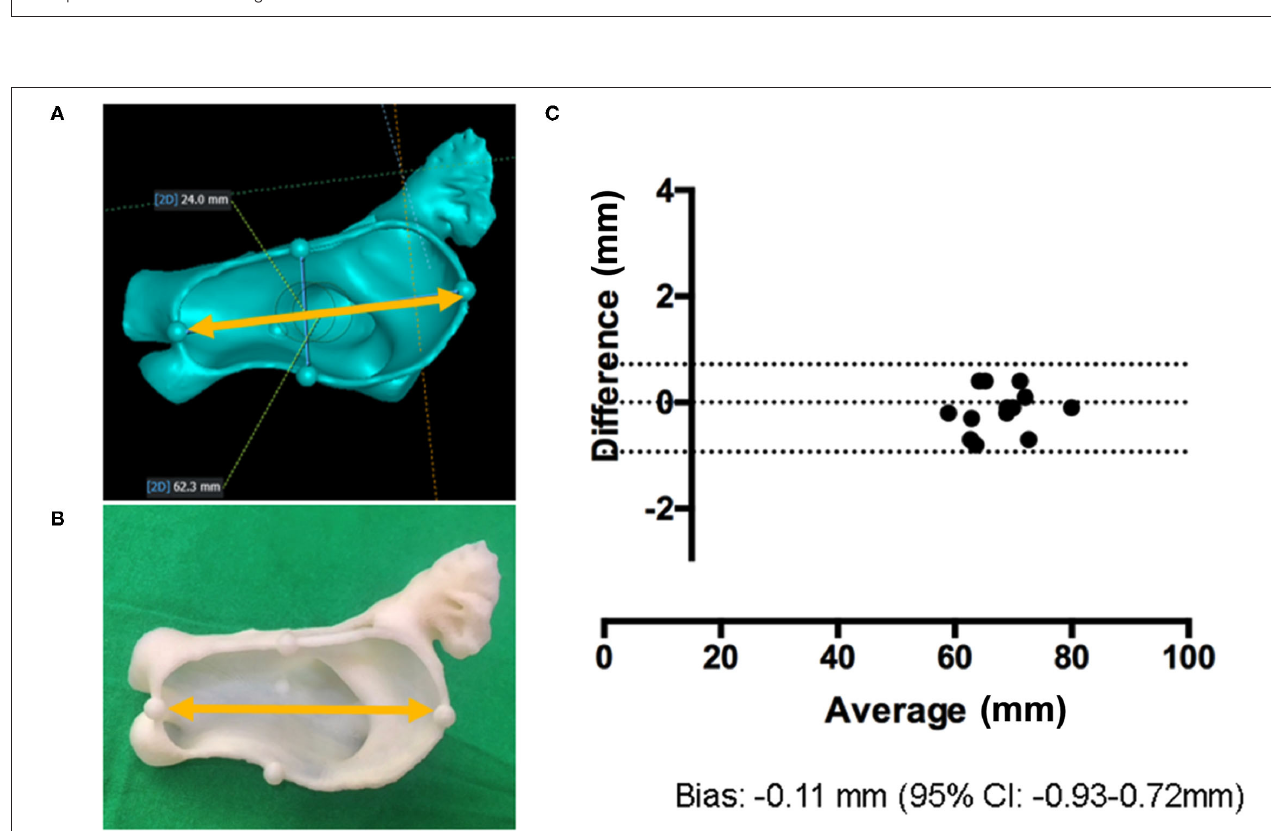
FIGURE 2 | Validation of the 3D-printed LA model. (A) Artificial markings are added to 3D image and the distance between them is measured (yellow arrow). (B) The horizontal diameter in 3D-printed LA models is measured (yellow arrow). (C) The Bland–Altman plot comparing the horizontal diameter of 3D images and 3D-printed models.